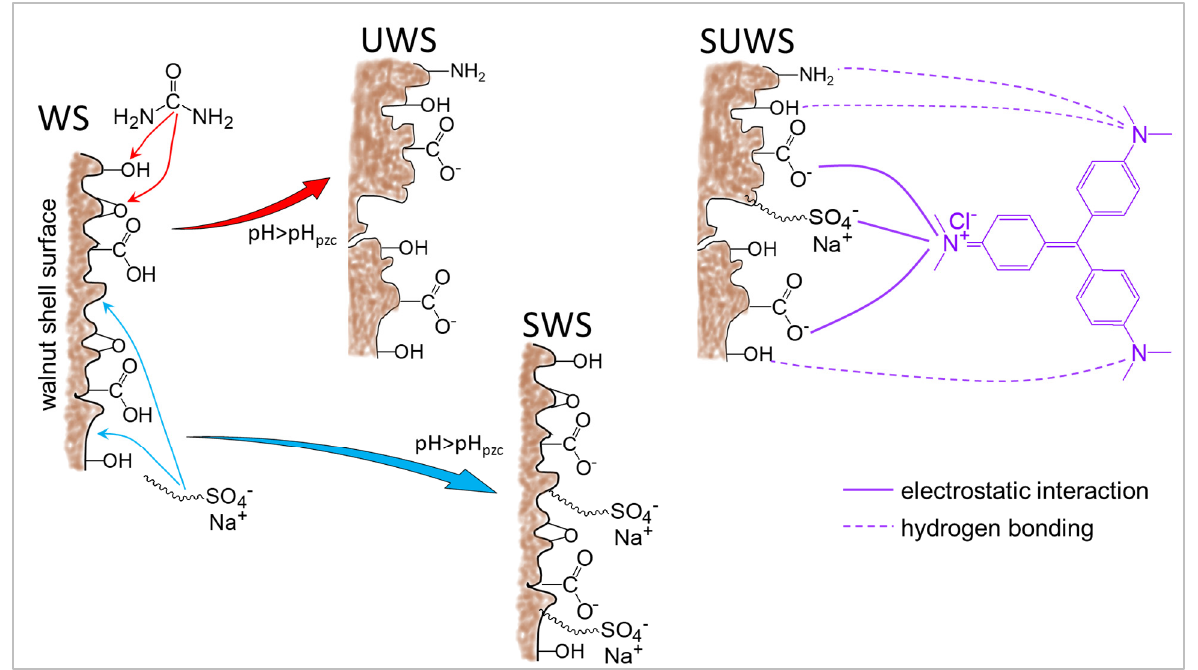
Figure 7. Proposed adsorption mechanism of CV onto WS-based biosorbents .